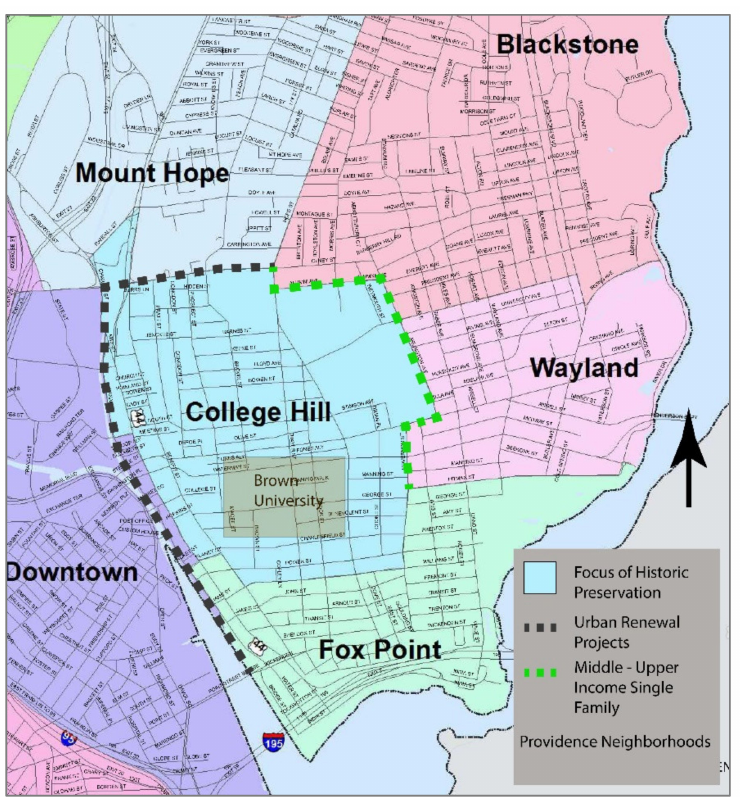
Figure 1. Conceptual map of bounded expansion of Brown University circa